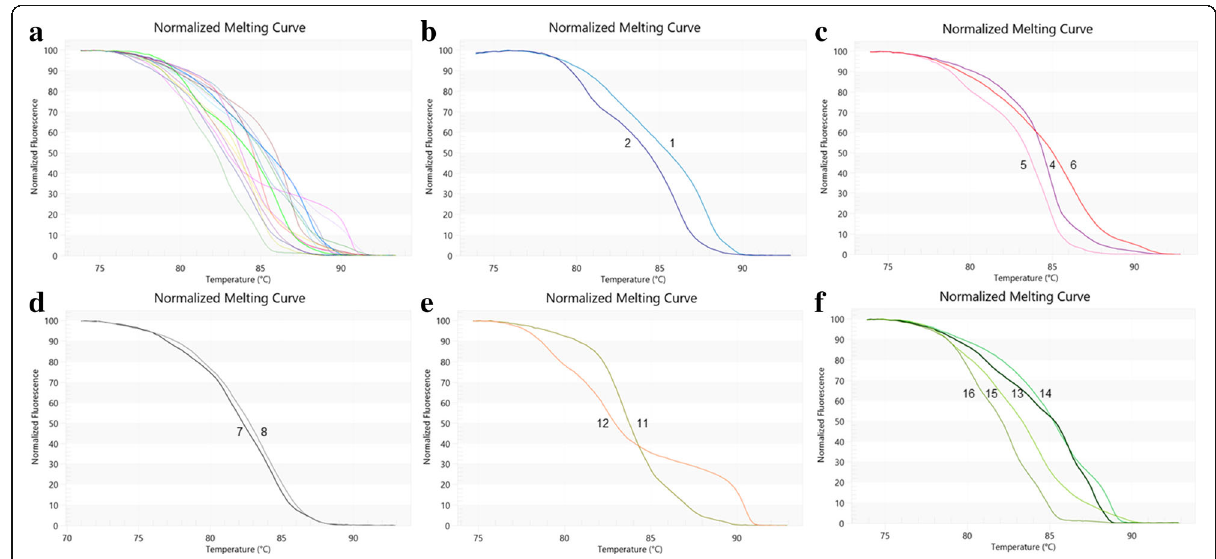
Fig. 4 Melting profiles of 16 Acathaceae species generating from HRM analysis using ITS2 primers. Normalised curves of ( a ) all 16 species, ( b ) species from genus Acanthus , ( c ) species from genus Barleria , ( d ) species from genus Clinacanthus , ( e ) species from genus Rhinacanthus , and ( f ) species from genus